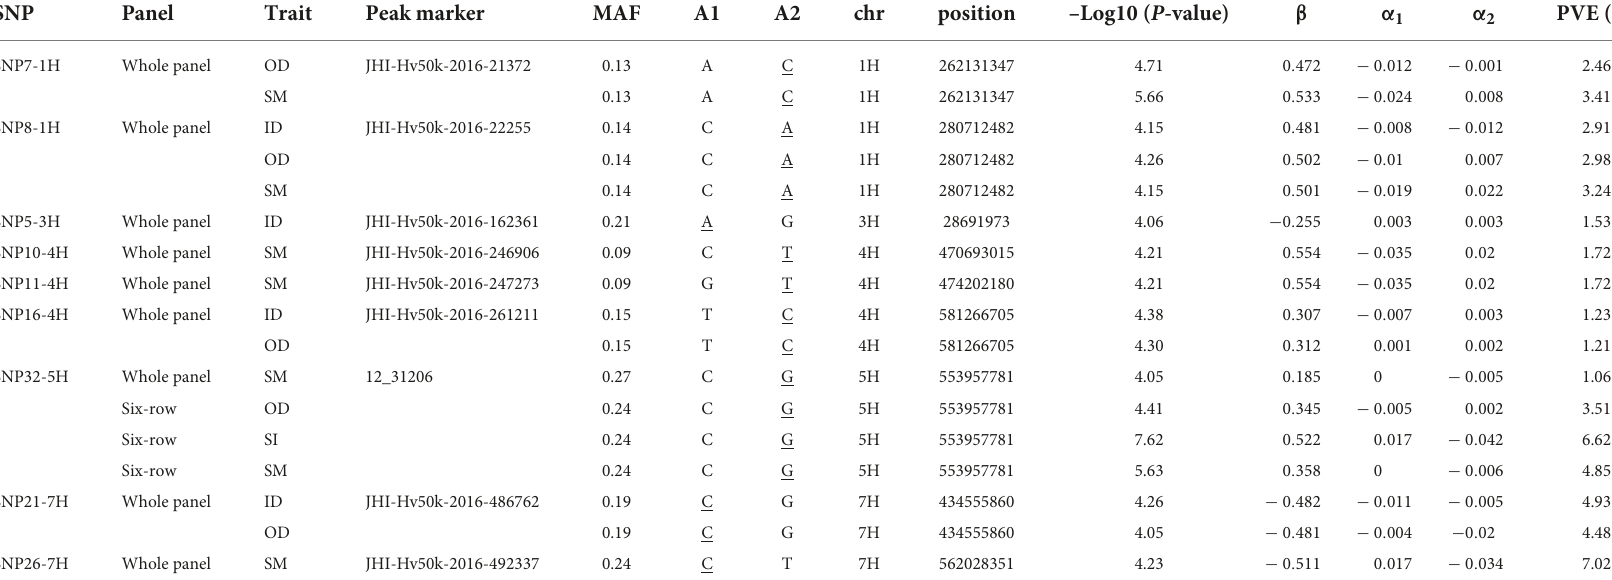
TABLE 3 Details of subset of SNPs with main effects and associated with culm traits with negative effects on lodging without impacting on plant